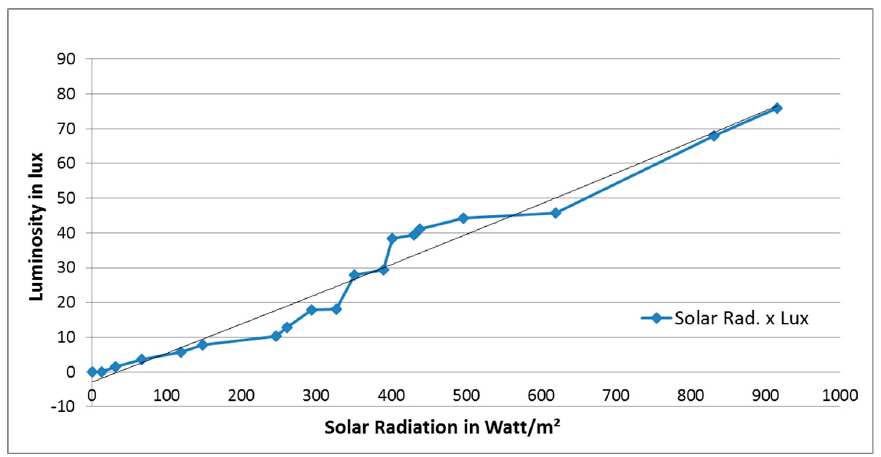
Figure 7. Relation between solar radiation and internal luminosity of the test room in which it has prototype pipe.